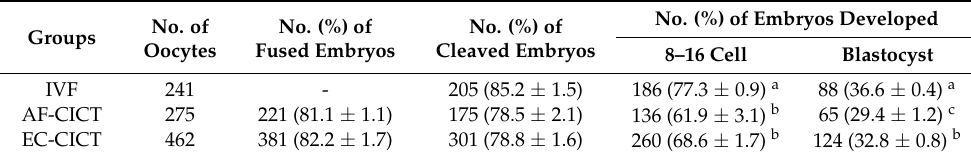
Figure 2. Effect of donor cell types on the developmental competence of bovine CICT embryos. ( A ) Representative immunofluorescence images of CDX2/DAPI in blastocysts. Embryos were stained for CDX2 (red) and DNA (DAPI, blue). Bar = 100 µ m. Quantification of the ( B ) total cell number (TCN), inner cell mass (ICM) and trophectoderm (TE) cell numbers, and ( C ) ICM/TCN ratios ( n = 10 per group). ( D ) Quantitative real-time polymerase chain reaction (RT-qPCR) results for pluripotency-related genes in blastocysts ( n = 5 per group). Table 1. Developmental competence and quality of IVF and CICT embryos produced using different types of donor